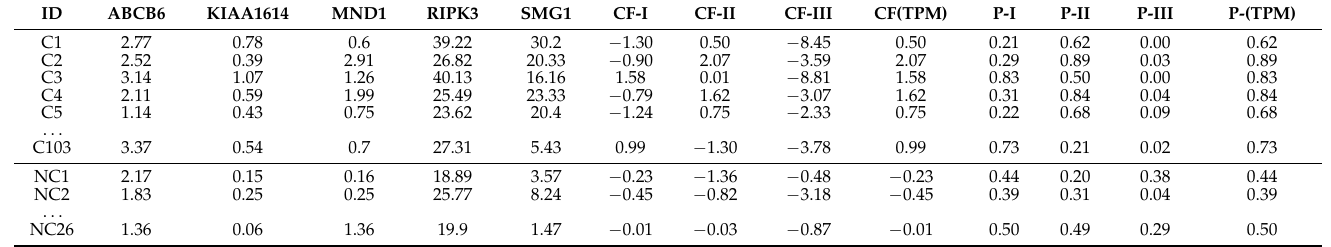
Table 2. TPM data: Expression values of the five critical genes, competing classifier factors, and predicted probabilities.